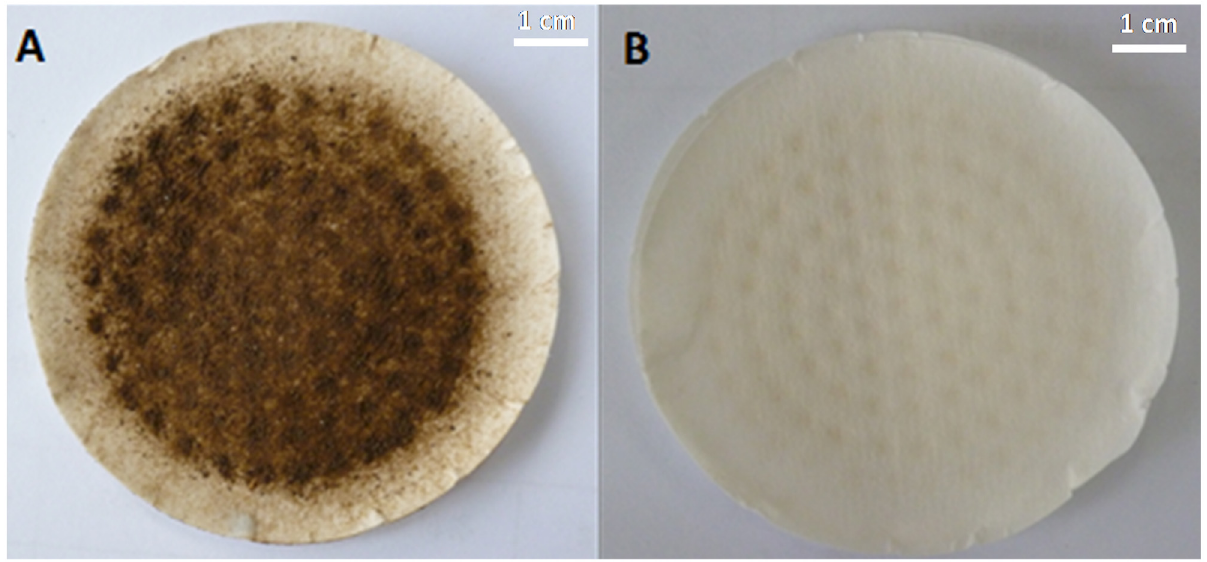
Fig 2. The extracts from oyster adductor muscle scars with and without pigmentation. Panel A, the extract from the pigmented adductor muscle scars; panel B, the extract from the nonpigmented adductor muscle scars.